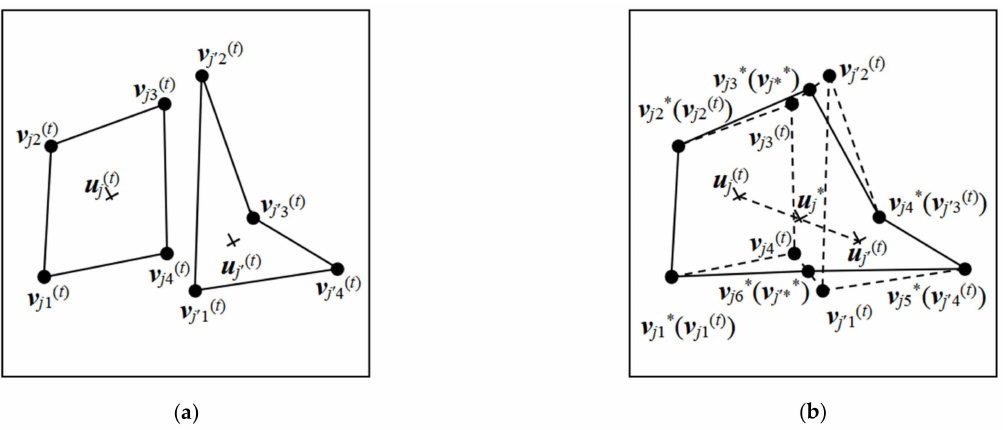
Figure 4. The example of merge polygons: ( a ) Configuration w ( t ) of object; ( b ) Merge polygons.